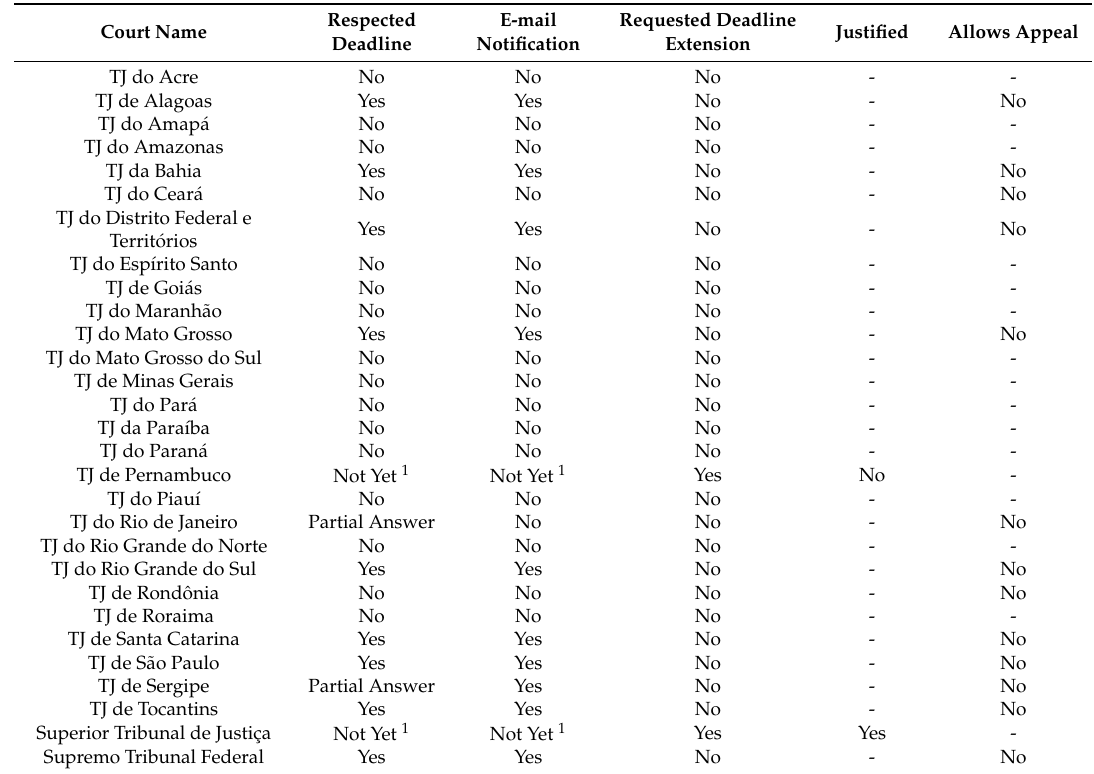
Table 2. Information access request